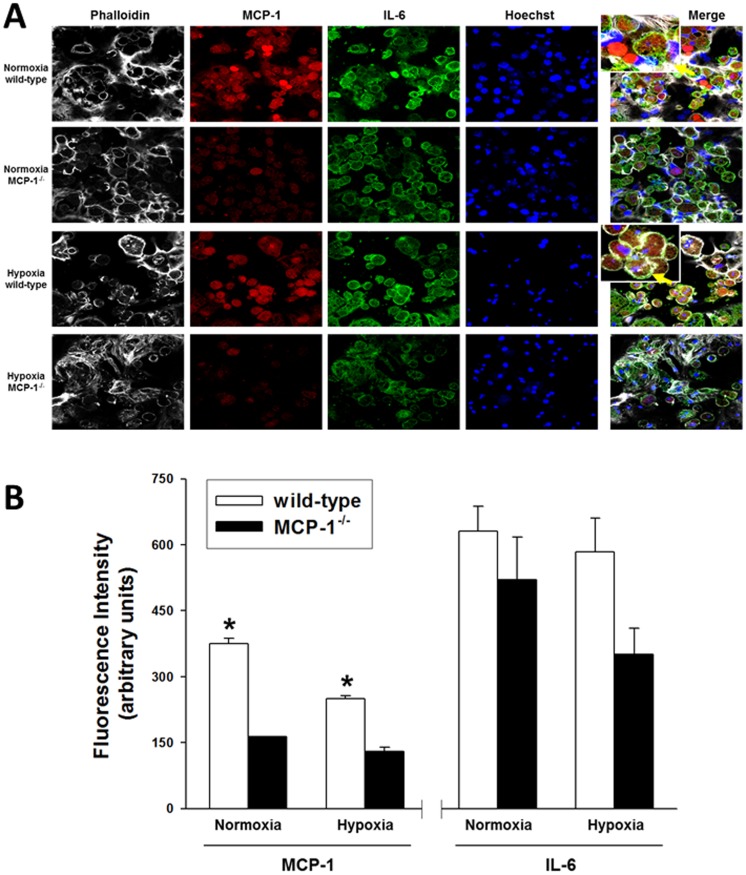
Differential expression of MCP-1 and IL-6 in wild-type and MCP-1−/− hepatocytes.Primary hepatocytes isolated from wild-type and MCP-1−/− mice (n = 3 each) were cultured under normoxic and hypoxic conditions for 48 h in three independent experiments. The cells were then fixed and processed for confocal immunofluorescence imaging as described in the
Materials and Methods
. (A) Fluorescent labeling: Phalloidin (white), MCP-1 (red), IL-6 (green), Hoechst (blue). (B) Quantification of immunostained cells (fluorescence intensity from 600–700 hepatocytes from 3 independent fields, n = 3 coverslips/experiment). Results are the mean ± SEM (*P<0.001 wild-type vs. MCP-1−/−, analyzed by t-test).